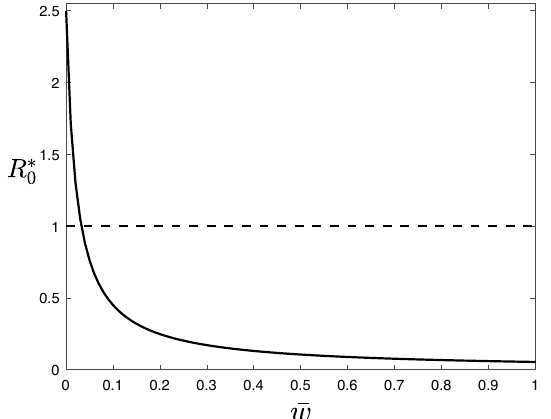
Figure 1. R ∗ 0 ( ¯ w ) for system (1) at the disease-free equilibrium given by (2). The critical vaccination rate is given by the intersection of R ∗ 0 ( ¯ w ) with the dashed line R ∗ ( ¯ w ) = 1 . Parameters: γ 1 = 1 , γ 2 = 1 , γ 3 = 0.9 , δ v 1 = 1 / 40 , δ v 2 = 1 / 52 , δ v 3 = 1 / 40 , p 1 = p 2 = p 3 = 1 , and β is scaled such that R 0 = 2.5 for the data set from Italy in the absence of vaccinated individuals ( ¯ w = 0 ), see “Results” for